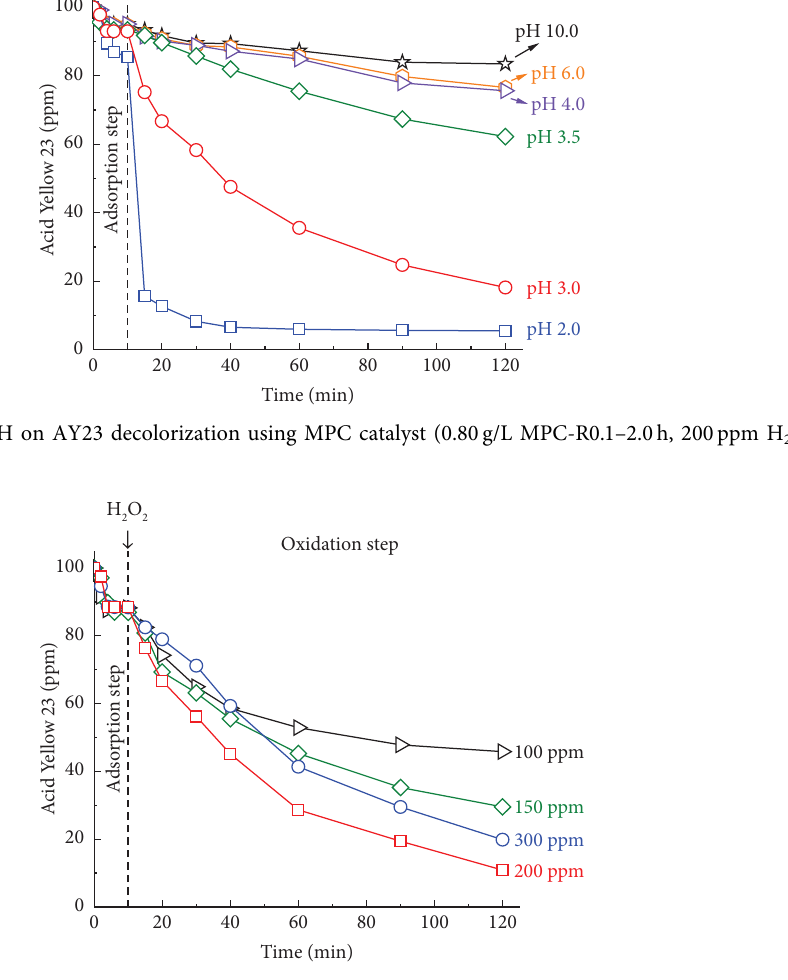
Figure 15: Efect of H 2 O 2 dosage on AY23 decolorization using MPC catalyst (0.80 g/L MPC-R0.1–2.0 h, pH 3.0, 200 ppm H 2 O 2